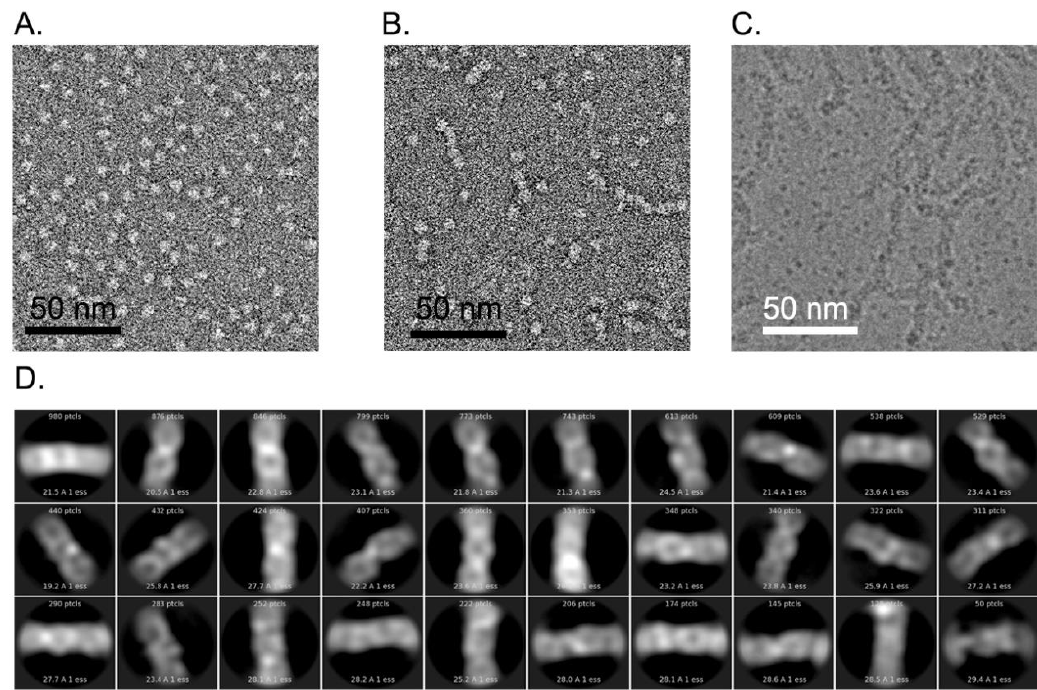
Figure 10. Electron microscopy of the complex between ZmNDPK1 and trim_A5U. ( A ) Image of a negatively stained ZmNDPK1 alone. ( B ) Image of the negatively stained ZmNDPK1 in complex with trim_A5U. ( C ) CryoEM image of ZmNDPK1 in complex with trim_A5U stain in vitreous ice. ( D ) Results of 2D classification of 30.000 filament segments picked from the cryoEM images.